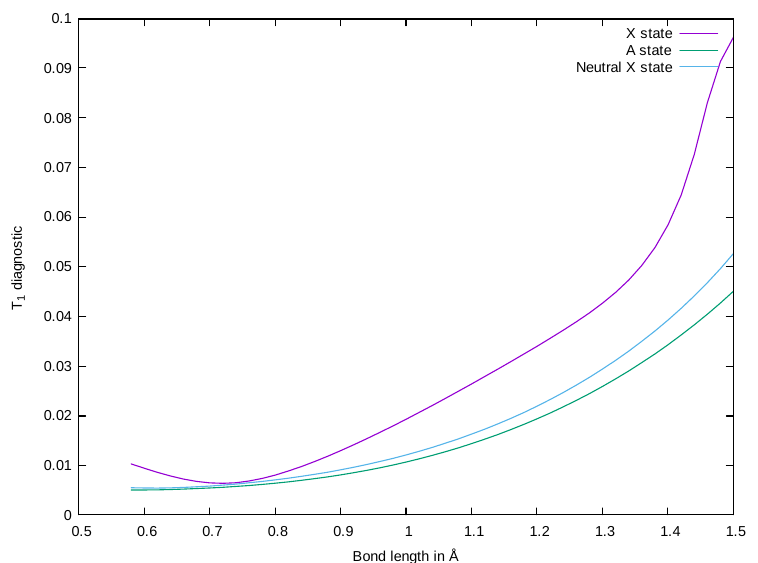
Figure 1. T 1 Diagnostic vs. C–O bond length for selected electronic states of CO + and neutral CO. However, EOM-IP does not perform as well for the ˜B 2 Σ + state. EOM-IP QFFs all overestimate this frequency by more than 100 cm − 1 . This may indicate potential pitfalls for EOM-IP based QFFs, possibly due to lower quality dynamic correlation in this instance. EOM-EE-CC3 based QFFs, however, perform quite well for this state. The shorter equilibrium C-O bond length for the ˜B 2 Σ + state results in a lower T 1 diagnostic for the corresponding reference state and, hence, lower multi-reference